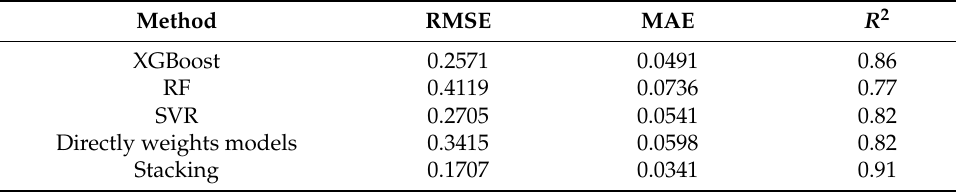
Table 6. Comparison of the prediction results for the single and stacking